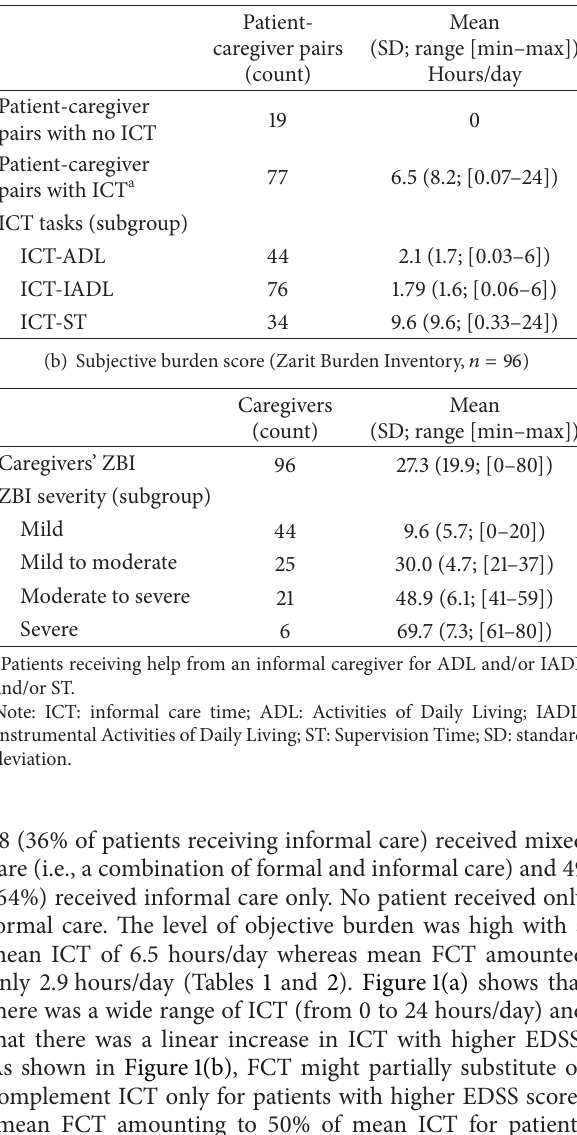
Table 2: Informal care burden